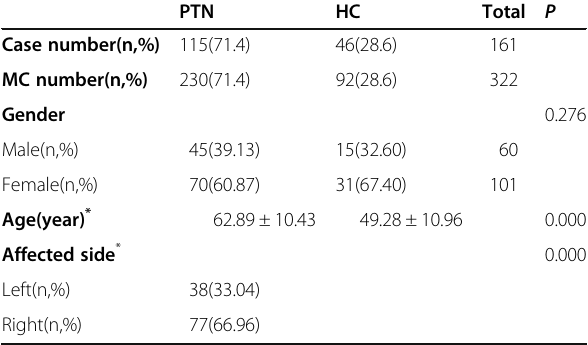
Table 1 Demographic characteristics of PTN and HC